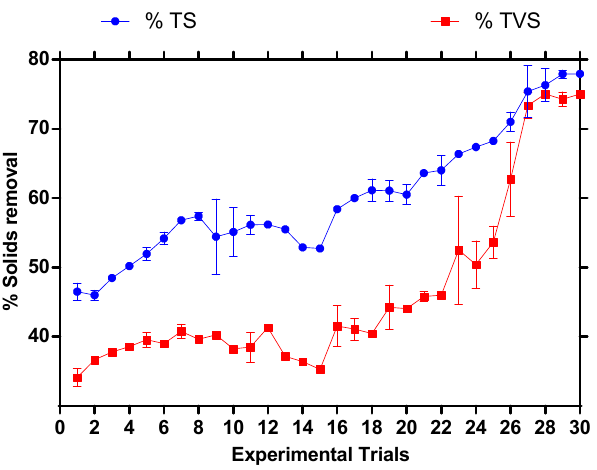
Figure 6. Solids removal by the CW.